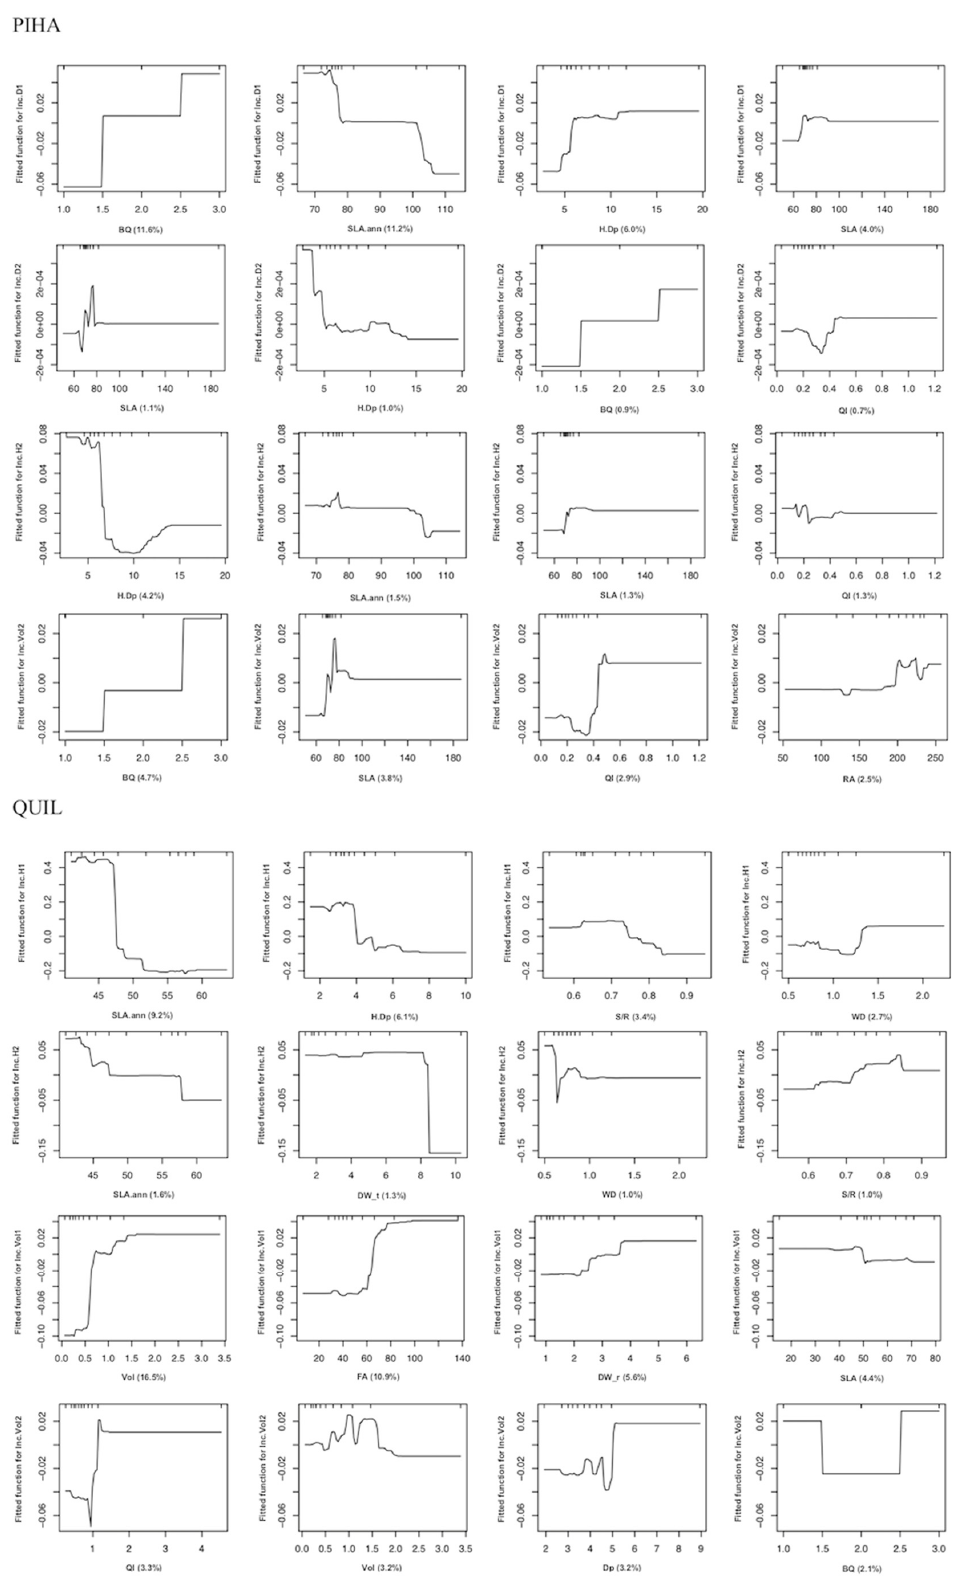
Figure 7. Partial dependence plots (PDP) of boosted regression tree (BRT) models showing the fitted functions of the 4 highest-ranked predictors (higher RI in the BRT models) on the early growth performance (monthly lapse) of Aleppo pine and Holm oak: diameter growth (IncD), height